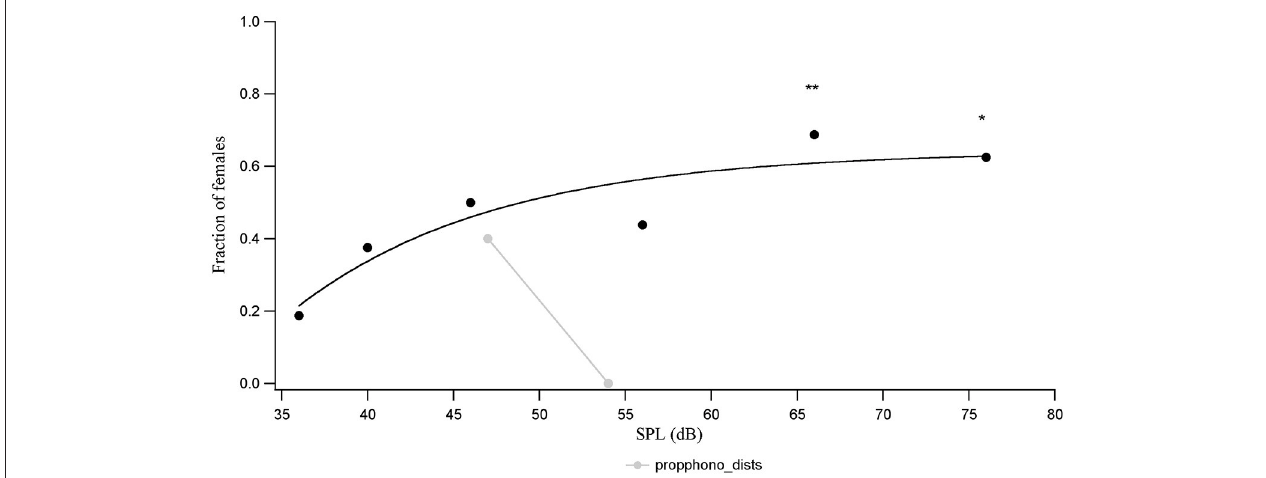
FIGURE 3 | The proportion of animals ( n = 16) who complete phonotaxis vs. conspecific call SPL, compared to the proportion of animals seen to complete phonotaxis in the semi-natural experiments at 4 and 9m distances (corresponding to acoustic call SPLs of 54 and 47 dB SPL, respectively). * p < 0.05 and ** p < 0.01 for comparisons of response at a given SPL with the response to silent controls.